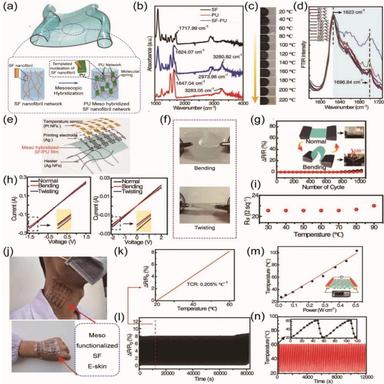
(a) Schematic illustration of crystal networks of meso dopped SF E-skin. (b) FTIR spectra of the SF-PU film compared with neat SF and neat PU. (c) Photographic image of different SF-PU films under temperature gradients during the same time (20 min). (d) FTIR spectra of the SF-PU films treated under temperature gradients, with the peak nearby 1623 cm− 1 demonstrating β-conformations. (e) Scheme of E-skin realizing heating and temperature detection. (f) Photographs of the unit from meso functionalized SF E-sk